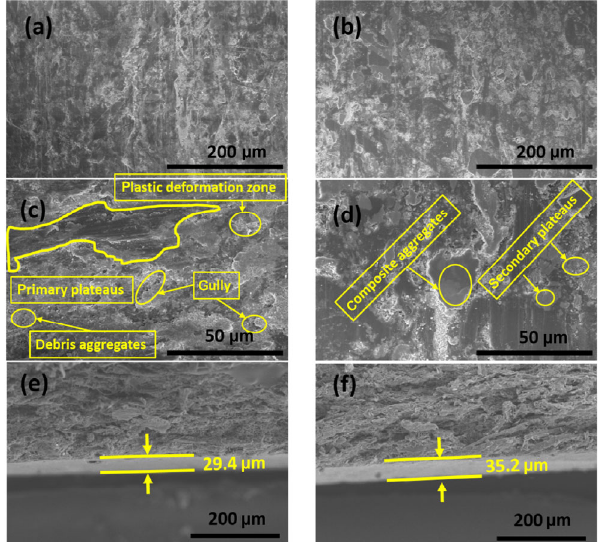
Fig. 8 SEM micrographs of worn surfaces and cross sections of the friction materials after testing: (a, c, e) NGC and (b, d, f) EGC ((a, b): 250×, (c, d): 1000× , and (e, f) cross sections: